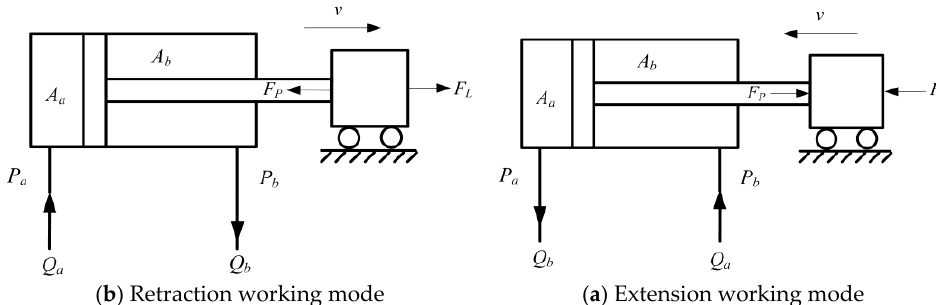
Figure 9. Two working modes with external active load.